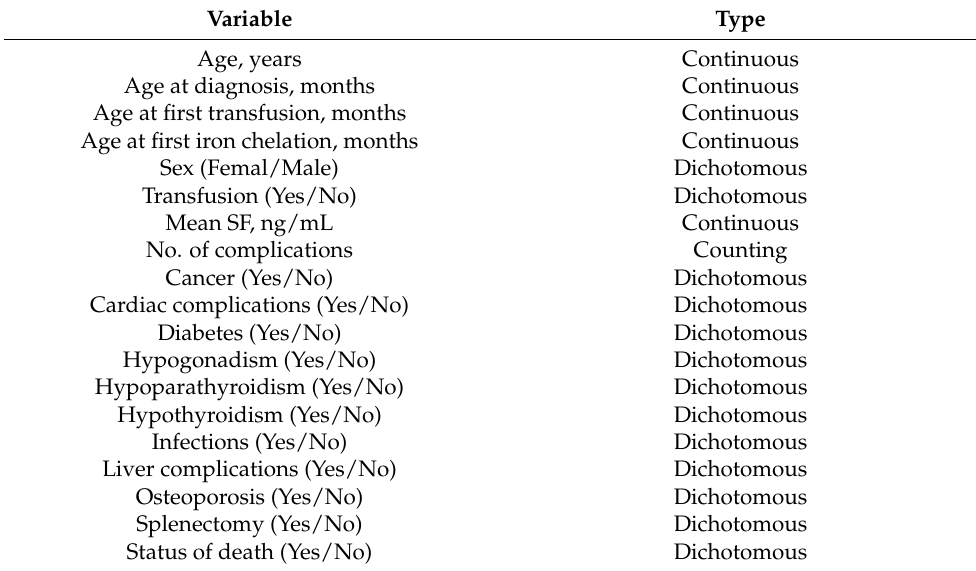
Table 1. Indicators of phenotype severity (IPhS) in β -thalassemia, chosen by the International Working Group on Thalassemia (IWG-THAL) members. Variable Type Age, years